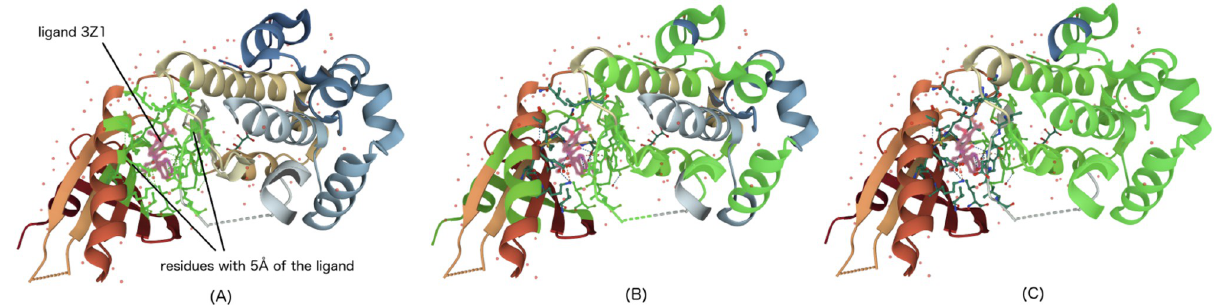
Fig 9. 3D visualization of CPI between PERK and the ligand 3Z1 (PDB ID 4X7J): (A) structure retrieved from PDB; (B) explanation from the model with kernel size k = 6; and (C) explanation from the model with kernel size k = 12. The central structure in pink color is the ligand 3Z1. The green part in (A) denote the residues located within 5 Å of the ligand, whereas the green regions in (B) and (C) correspond to the residues that contribute most ( � 0.2) to the CPI prediction. The contribution values are taken from the corresponding heat maps in Fig 8 with cut off value 0.2.